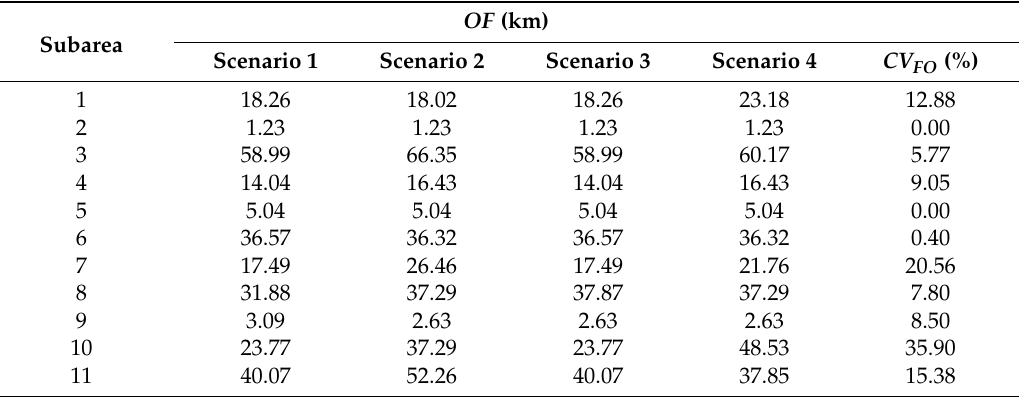
Table 1. Objective function ( OF ) values that represent the sum of the Euclidean distances of every tree extracted into their yards, considering the scenarios for each subarea.